Question: Sum up the contents of this chart in one sentence.
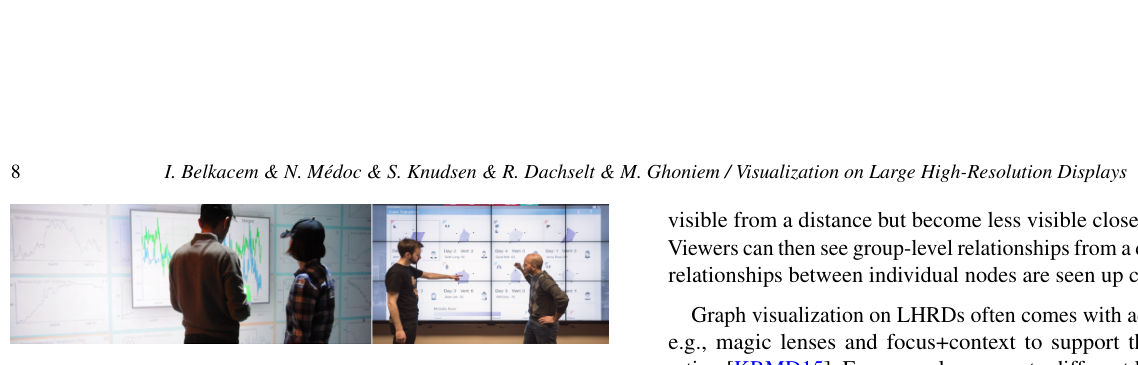
Answer: Temporal data visualization. Collaborative visual analysis of (left) multi-sensor time-series in a building [BAEI16]; (right) a summary overview of patient data over time [TKAM17].